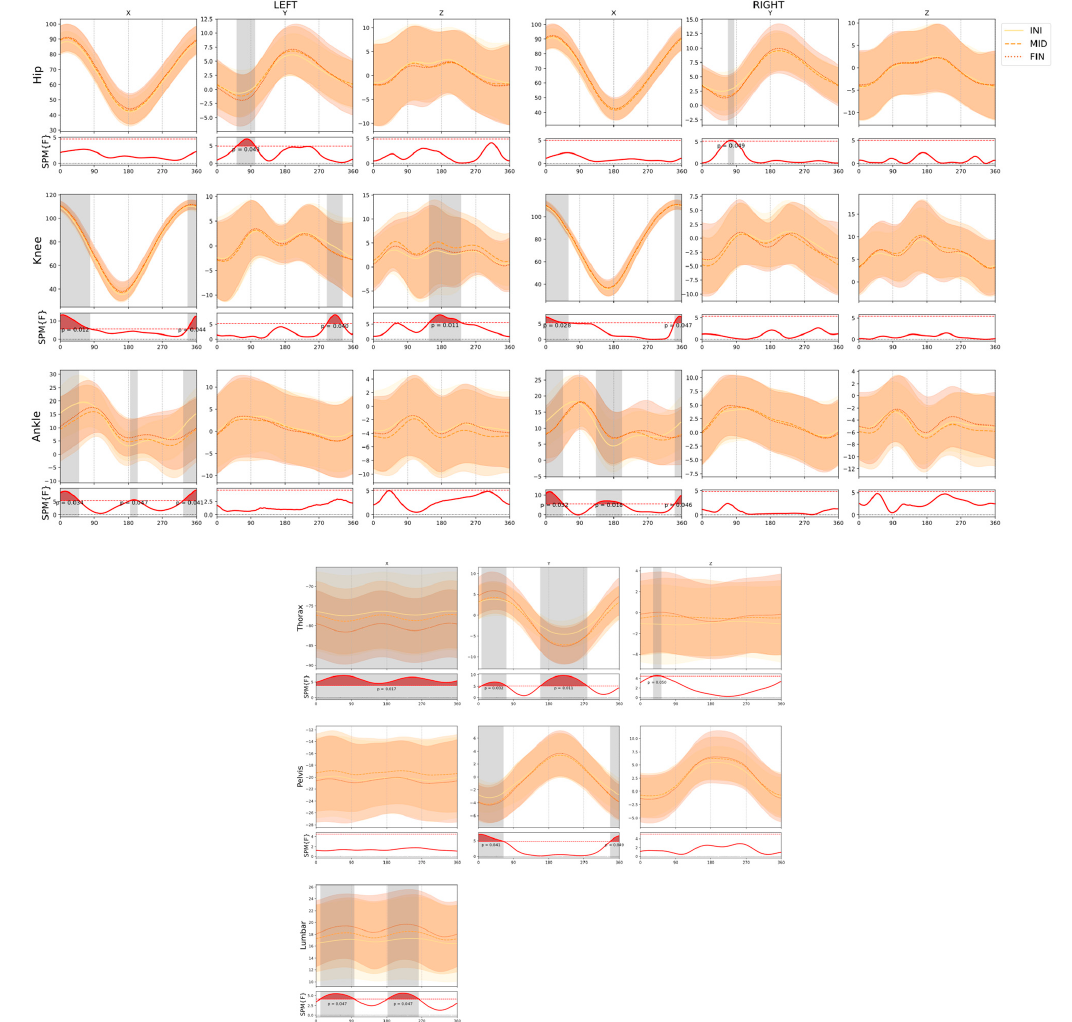
Figure 3. Comparison of the joint and segment angles across the time in the test. Lower panels display statistical parametric mapping F values from the repeated measures ANOVA, with the dotted line representing the critical threshold. Red and grey shaded areas indicate statistical differences among conditions. Horizontal values represent one pedaling cycle, starting from the top position of the same side pedal. INI: measurement at 0 min, MID: measurement at 10 min, FIN: measurement at 20 min. SPM: statistical parametric mapping. x, y, z: movement in the sagittal, frontal, and transverse plane, respectively.